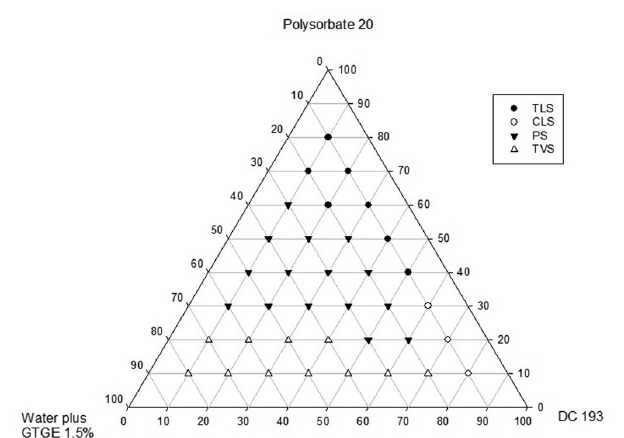
FIGURE 1 - Pseudoternary phase diagram produced by the investigated system using silicone glycol copolymer - DC 193 ® , polysorbate 20, and distilled water with green tea glycolic extracts 1.5%. The symbols indicate: ● - transparent liquid system, ○ - cloudy liquid system, ∆ - transparent viscous system and ▼ phase separation.